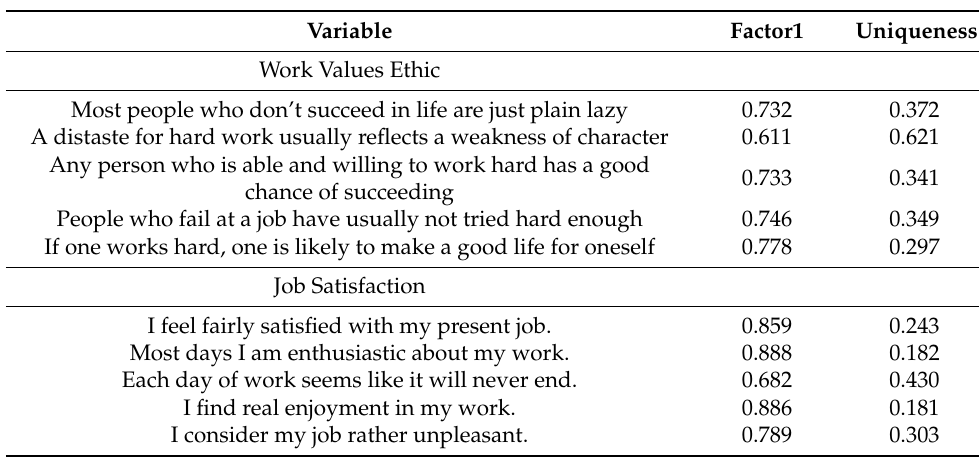
Table 2. Factor loading for work values ethic and job satisfaction.